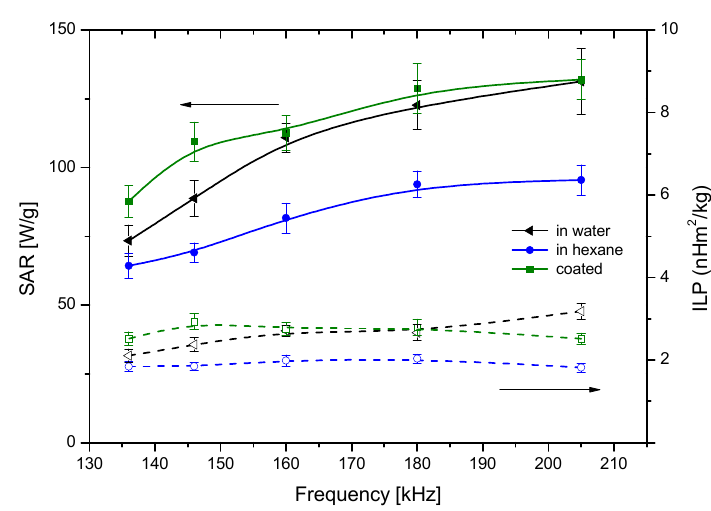
Figure 13. Specific absorption rate (SAR) (solid lines) and intrinsic loss power (ILP) (dotted line) values of the Fe 3 O 4 nanoparticles in water, in hexane and coated with PDMAEMA in water.